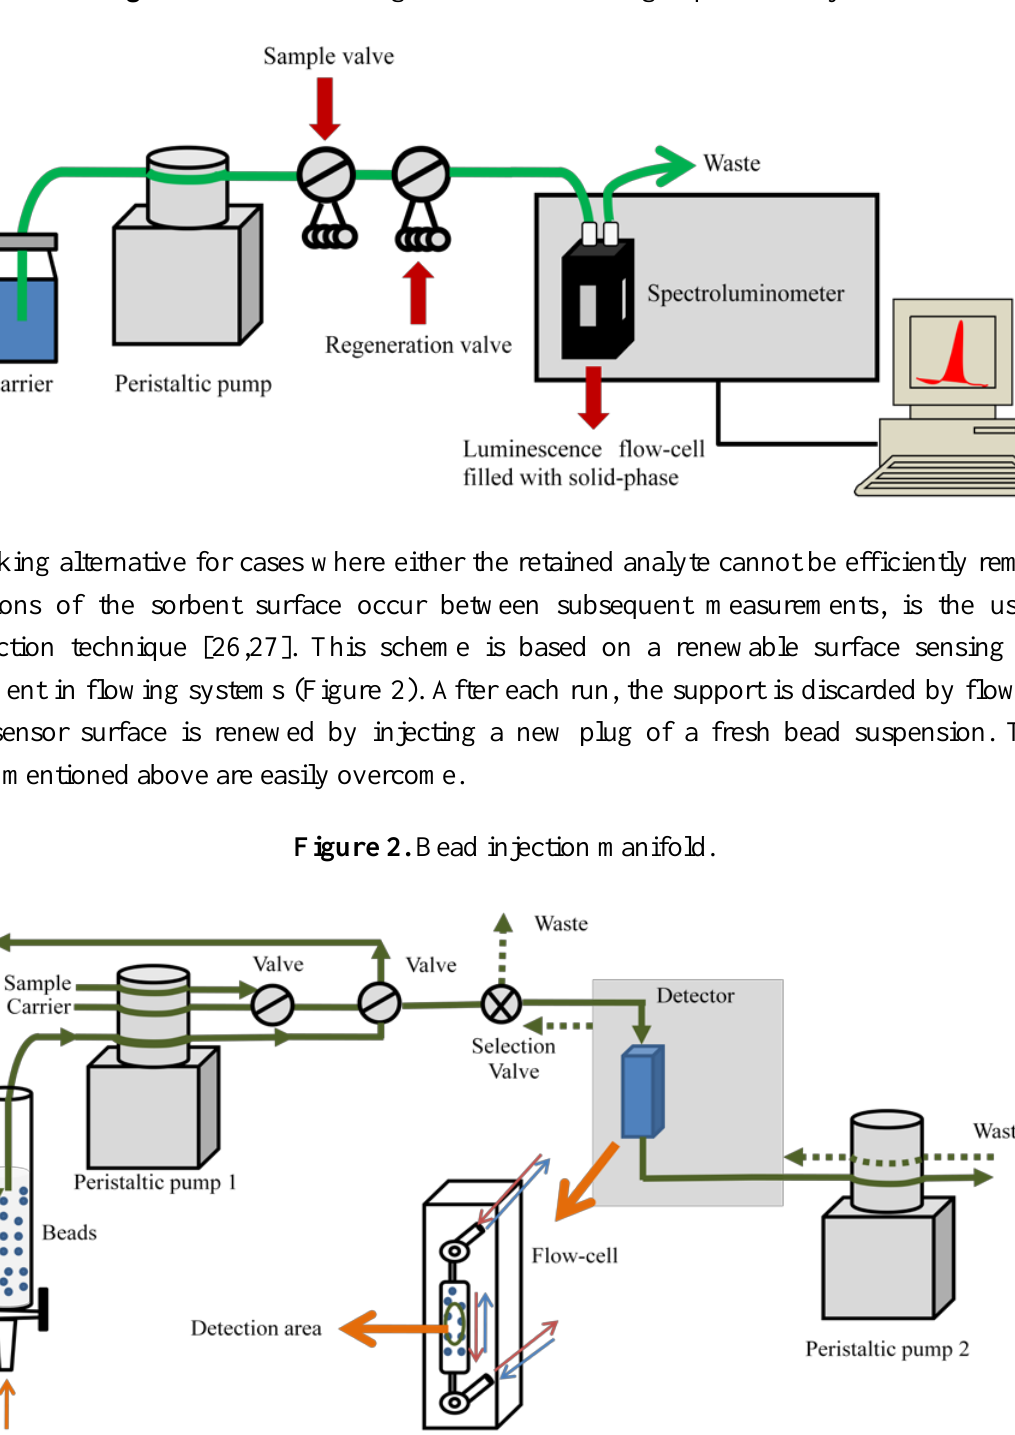
Figure 1. Schematic diagram of a flow-through optosensor system.